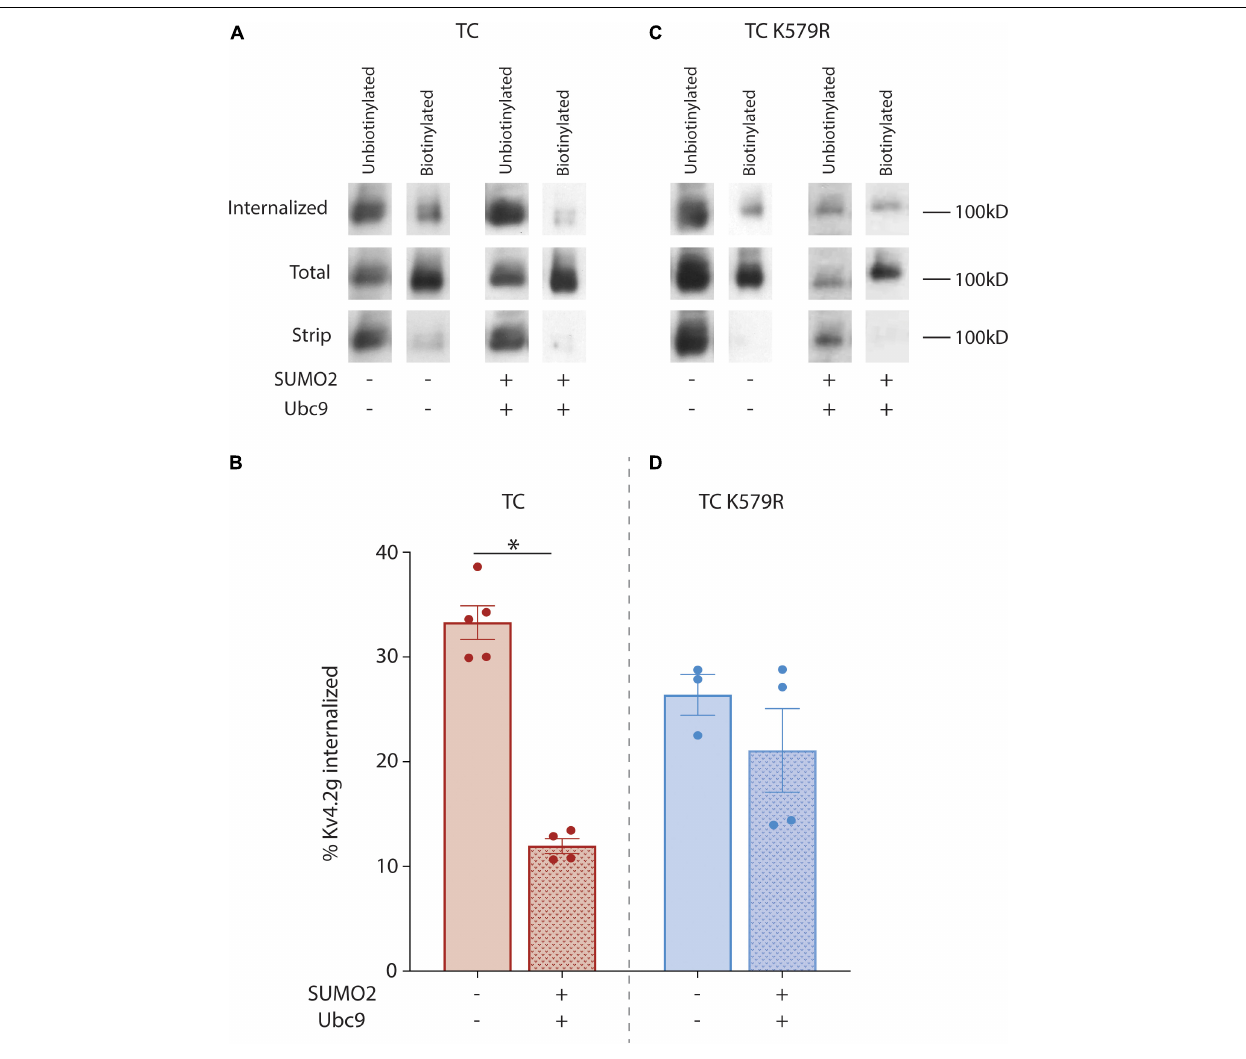
FIGURE 7 | SUMOylation of Kv4.2g at K579 reduces channel internalization. HEK cells were co-transfected with plasmids encoding HA-KChIP2a+HA-DPP10c with either Kv4.2g or Kv4.2g K579R. SUMOylation was (+) or was not (–) enhanced by co-expressing SUMO2 and Ubc9. Assays to measure internalization in the two treatment groups were performed as detailed in the text. (A,C) Western blots containing the unbiotinylated and biotinylated fractions from the internalized, total, and strip plate lysates for a representative experiment in each treatment group for wild-type and mutant TCs. Blots were probed with anti-GFP to visualize Kv4.2g α -subunits. (B,D) Bar graph representing the mean ± SEM percent internalization: (OD internalized, biotinylated fraction ÷ OD total, biotinylated fraction) × 100. The data for an experiment was only included if the stripping efficiency was > 90%: [1-(OD strip, biotinylated fraction ÷ OD total, biotinylated fraction)] × 100. Each data point represents one independent experiment. Asterisk, significantly different. TC: control, 33.3 ± 1.7% vs. SUMOs + Ubc9, 12 ± 0.7%, t -test p = < 0.0001; TC K579R: control, 26.4 ± 1.2% vs. SUMO2 + Ubc9, 21.1 ± 4%, t -test p =